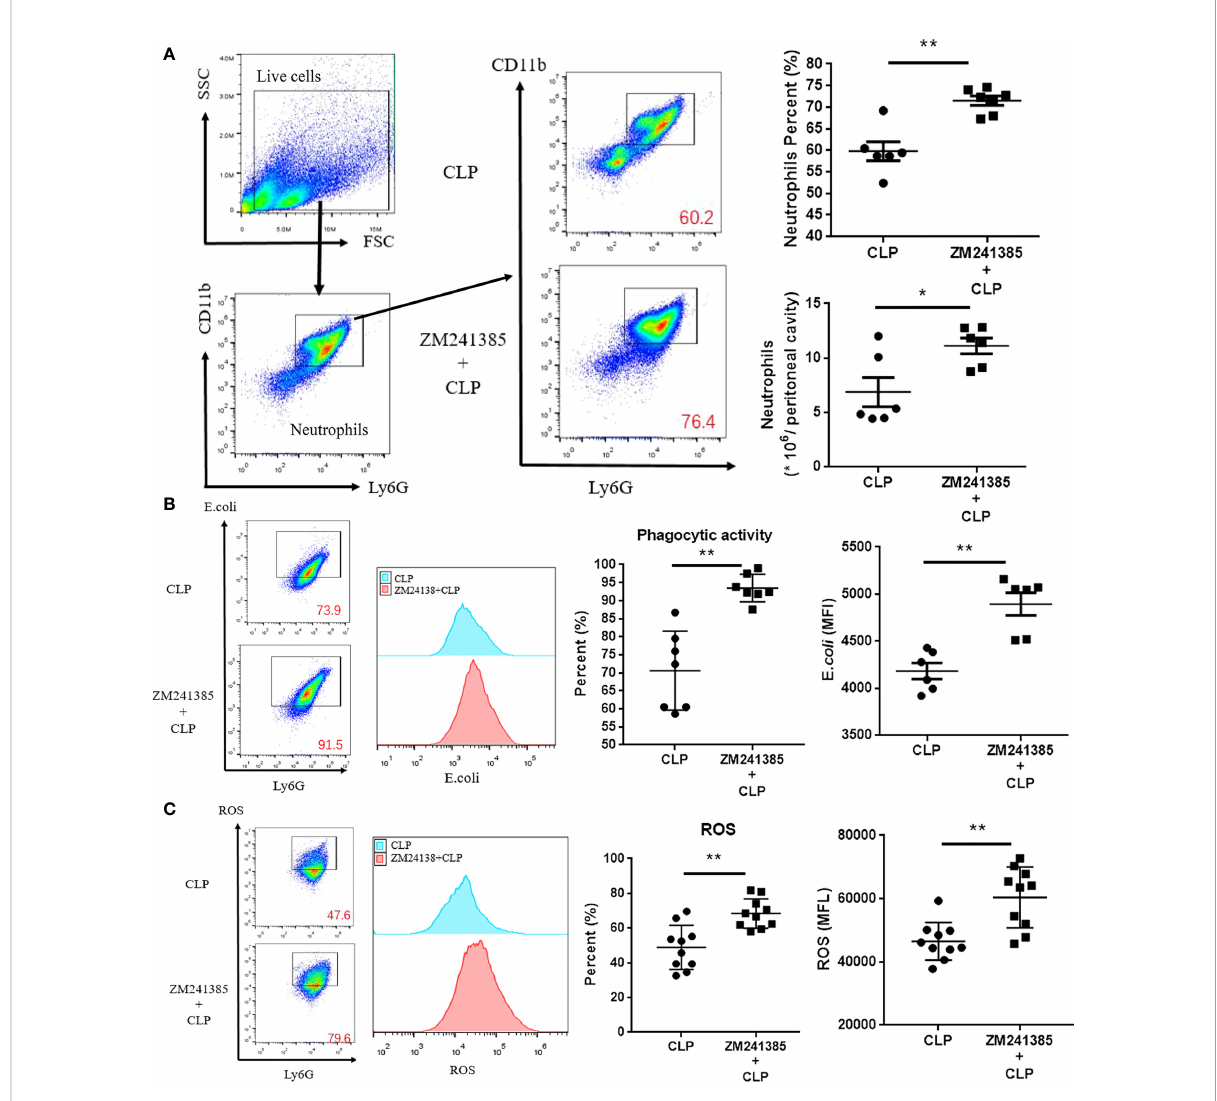
FIGURE 4 ZM241385 improves neutrophil phagocytosis and ROS generation in CLP-induced sepsis. Mice treated with vehicle or ZM241385 were collected for peritoneal cells 24 hours after CLP. Neutrophils were identi fi ed by Ly6G+CD11b+ in elevated numbers and percentages (A) and were assessed for phagocytic capacity (B) or ROS production (C) . In Fig. 3B and Fig. 3C panels, CD11b+ and Ly6G+ cells were gated fi rst, as in Fig. 3A. After that, all the cells in Fig. 3B and Fig. 3C were Ly6G+ and considered neutrophils. The Y axis of these panels is used to describe the function of neutrophils. The function of neutrophils is normal distribution. We make the same mistake in each test by drawing the rectangular box as the positive groups. Meanwhile, the fl uorescence curve was used to show the difference between each group. The individual mice are represented by symbols. * p < 0.05, ** p <